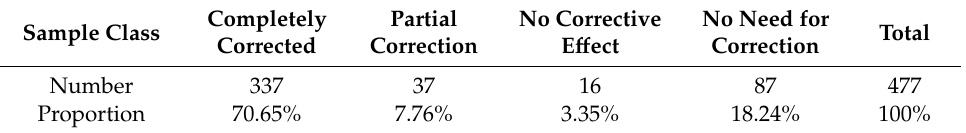
Table 8. Sample-based analysis of Sample Set 1 before and after correction.